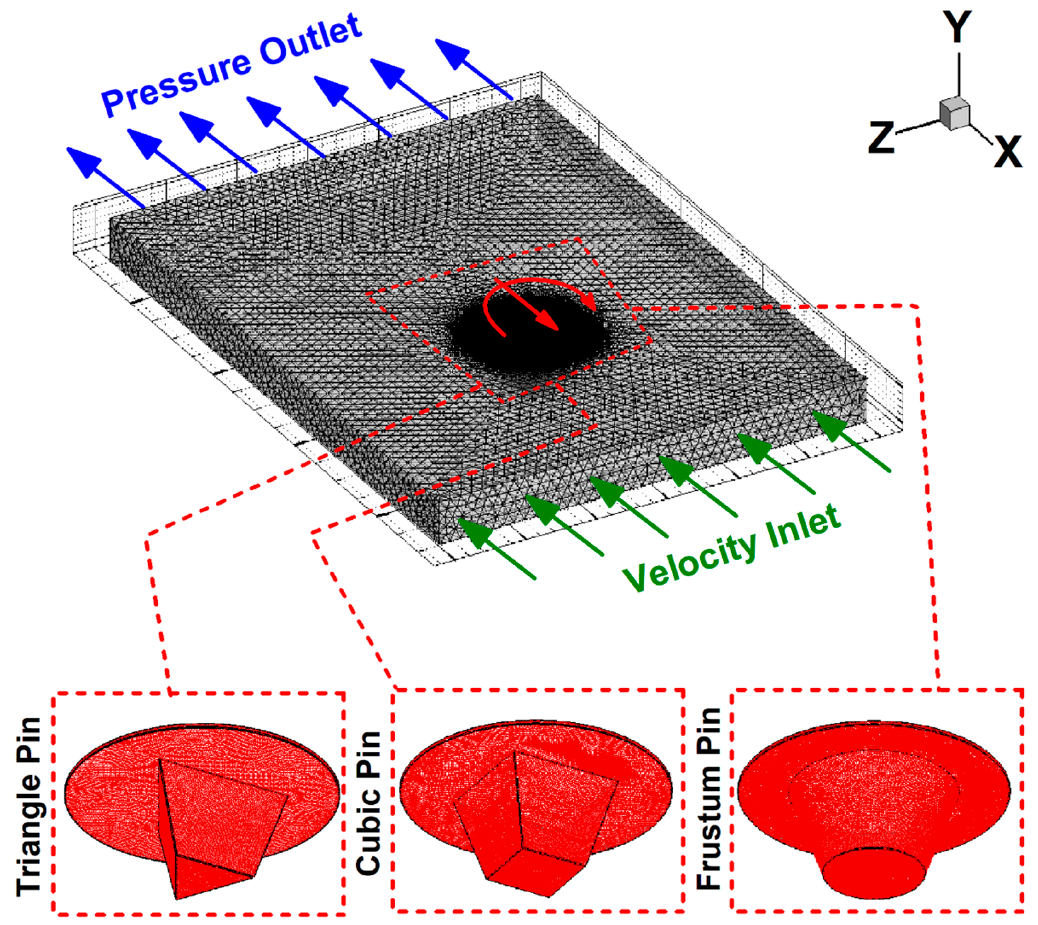
Figure 3. Meshed domain.